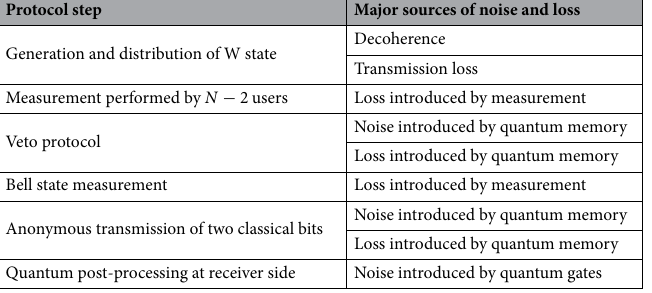
Table 2. Major sources of noise and loss in anonymous transmission